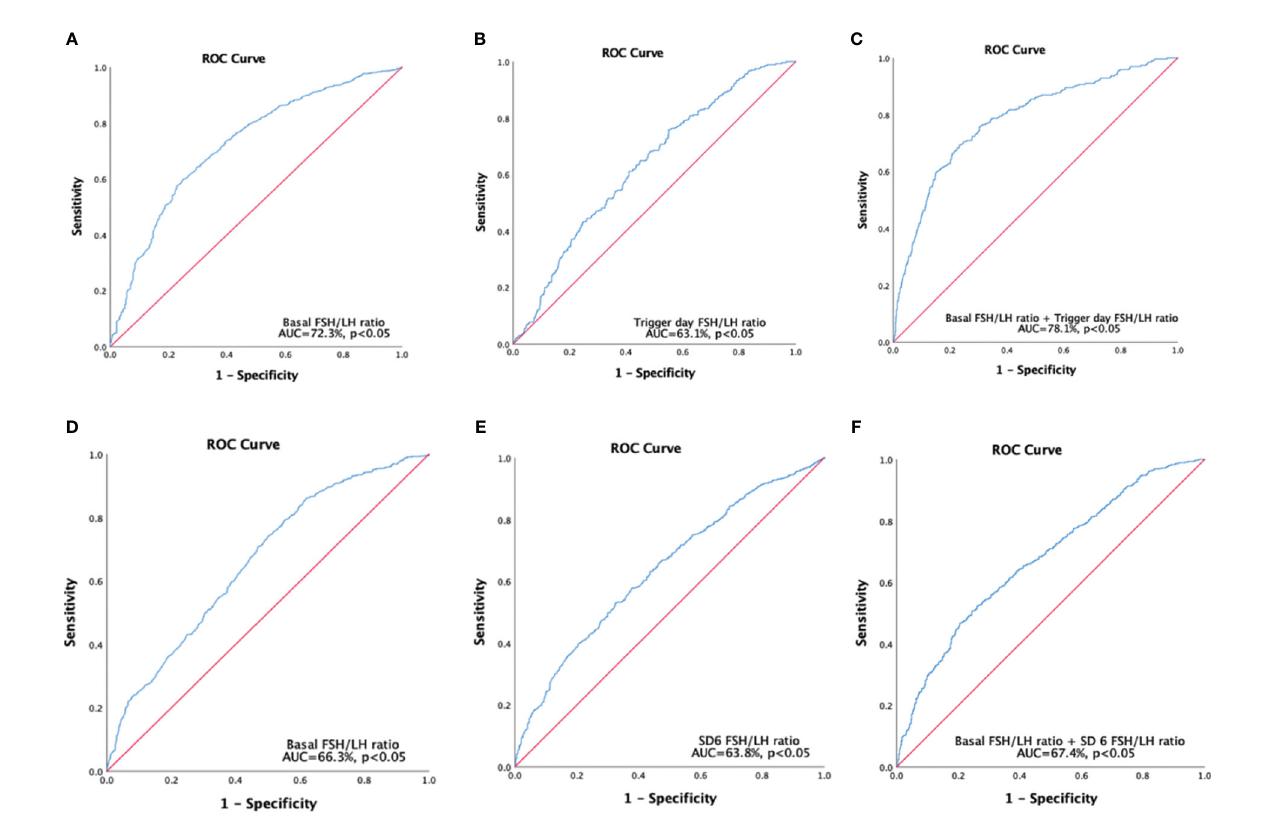
FIGURE 2 Receiver operating characteristics curves were constructed to predict poor responders (A-C) , and poor reproductive potential (D-F) . (A) Single variable for basal FSH/LH ratio, cutoff value=1.875. (B) Single variable for trigger, day FSH/LH ratio cutoff value =9.665. (C) Multivariable models for basal FSH/LH ratio + trigger day FSH/LH ratio; (D) Single variable for basal FSH/LH ratio, cutoff value=2.515. (E) Single variable for SD6 FSH/LH ratio, cutoff value=4.14. (F) Multivariable models for basal FSH/LH ratio + SD6 FSH/LH ratio. Poor responders refer to patients who retrieved oocytes ≤ 5; Poor reproductive potential refers to patients who obtained total available embryos ≤ 3.SD6: Stimulation Day